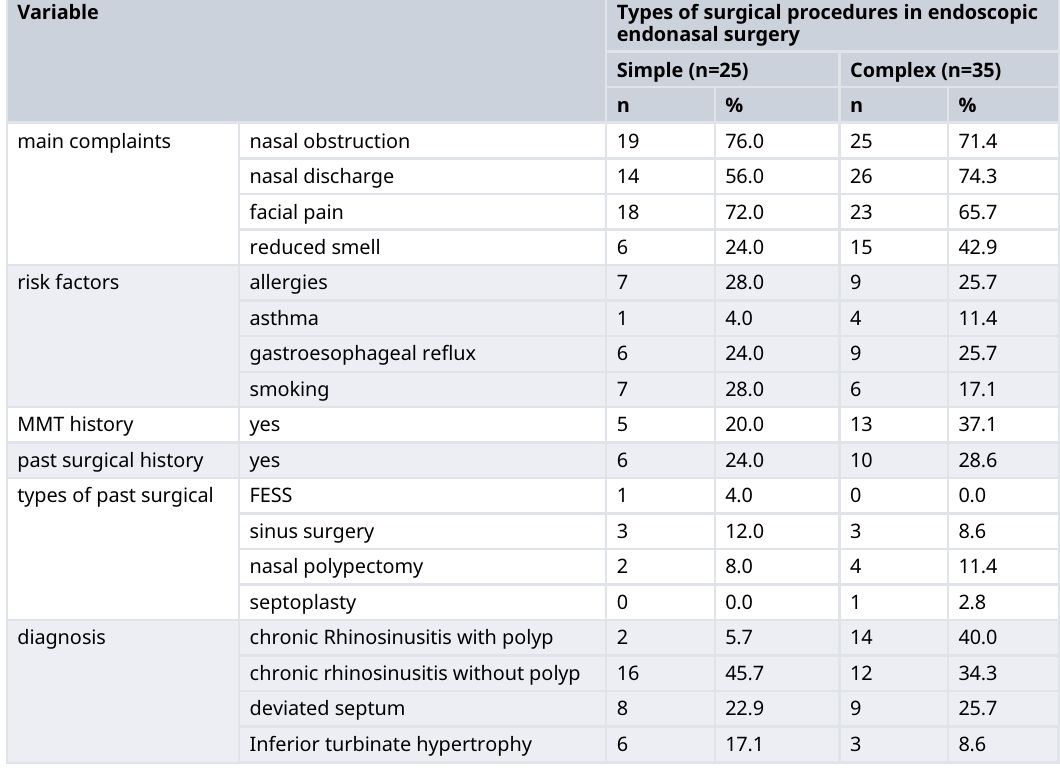
Table 2. Characteristic of postoperative care